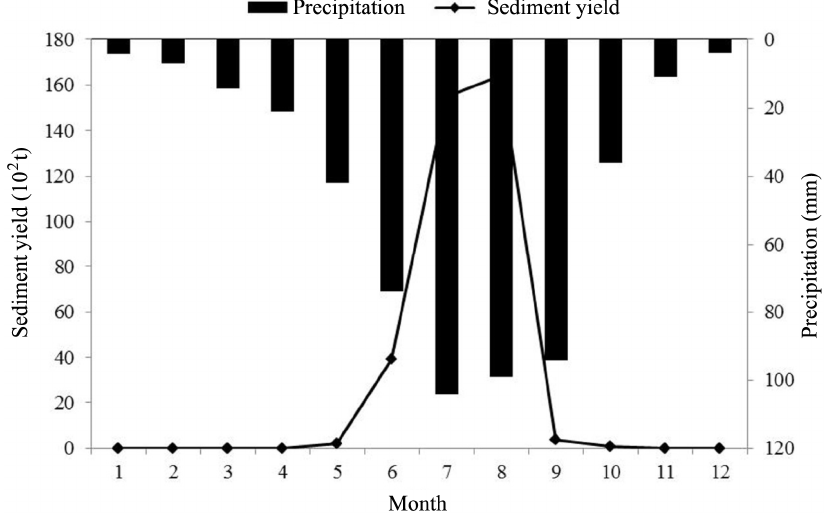
Figure 4. Comparison of the monthly measured sediment yield and